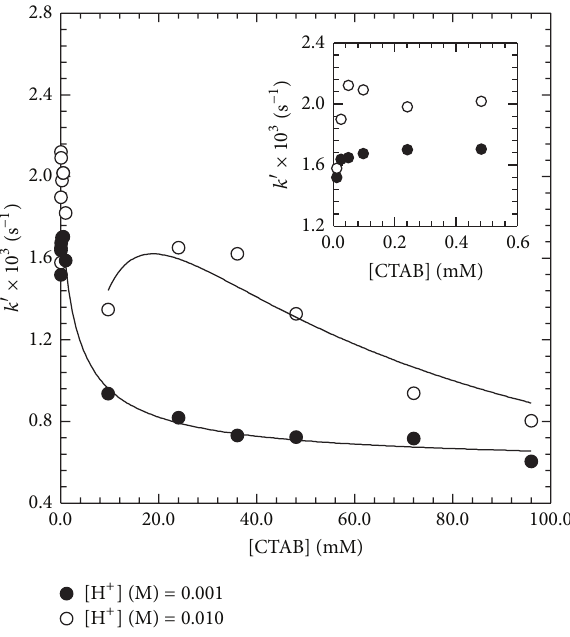
Figure 1: The 𝑘 󸀠 as a function of [CTAB] for acid hydrolysis of 2.21 × 10 −5 MBz. Inset shows the values of the 𝑘 󸀠 at [CTAB] below the